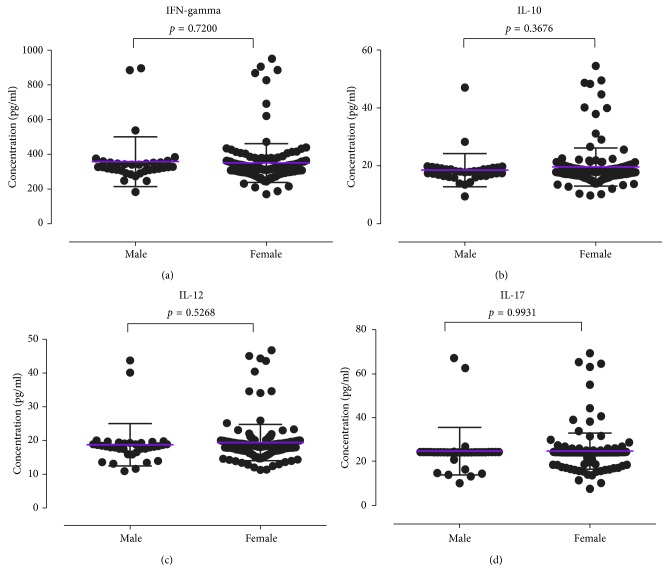
Cytokine distribution of the study participants stratified according to gender: (a) IFN-gamma, (b) IL-10, (c) IL-12, and (d) IL-17.